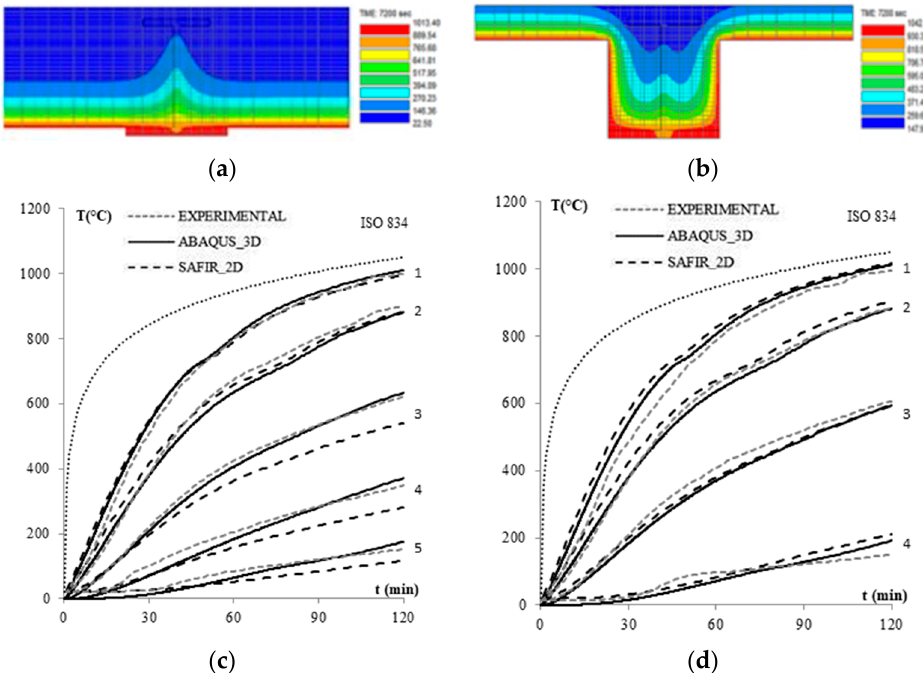
Figure 6. Thermal comparisons for WFRC 66162: ( a ) Thermal contours at section AA’ after 120 min, ( b ) Thermal contours at section BB’ after 120 min, ( c ) Test vs. FEM at section AA’ ( d ) Test vs. FEM at section BB’.